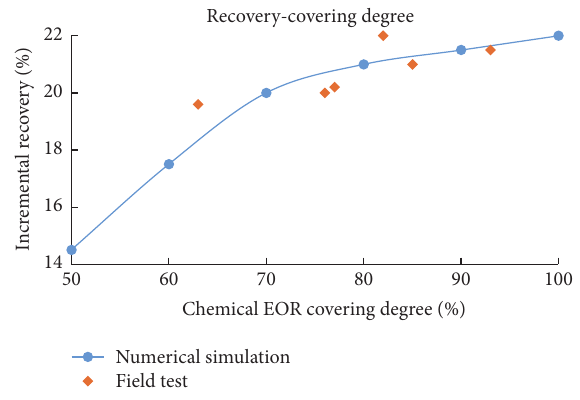
Figure 9: Relationship between covering degree and enhanced oil recovery factor